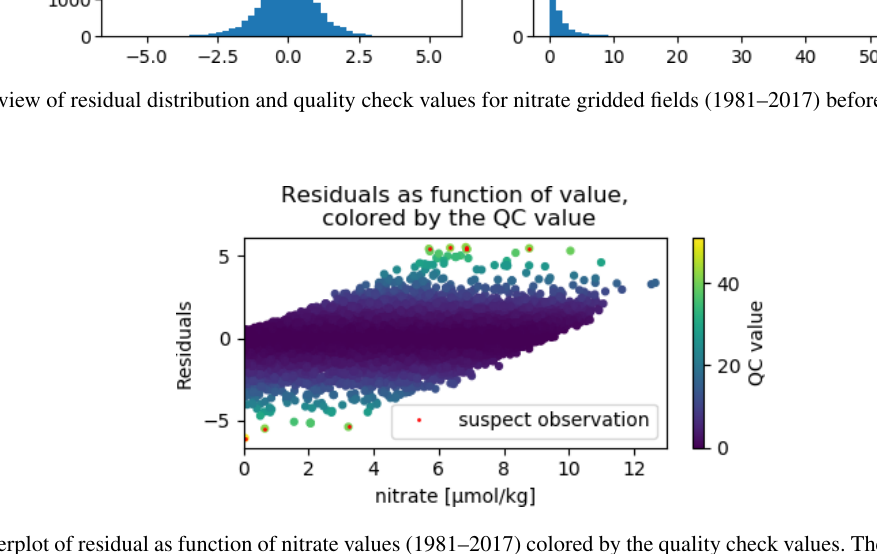
Figure B2. Scatterplot of residual as function of nitrate values (1981–2017) colored by the quality check values. The red dots are the suspect observation (points with QC values > 40).